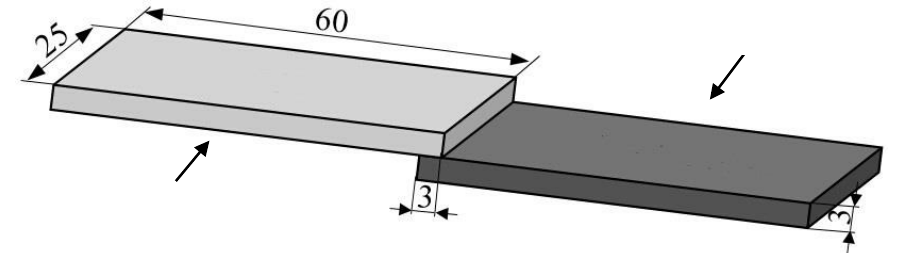
Figure 2. Schematic illustration of the brazed joint (mm).